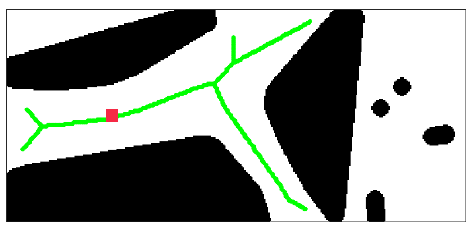
Figure 15. The searching result of the desired